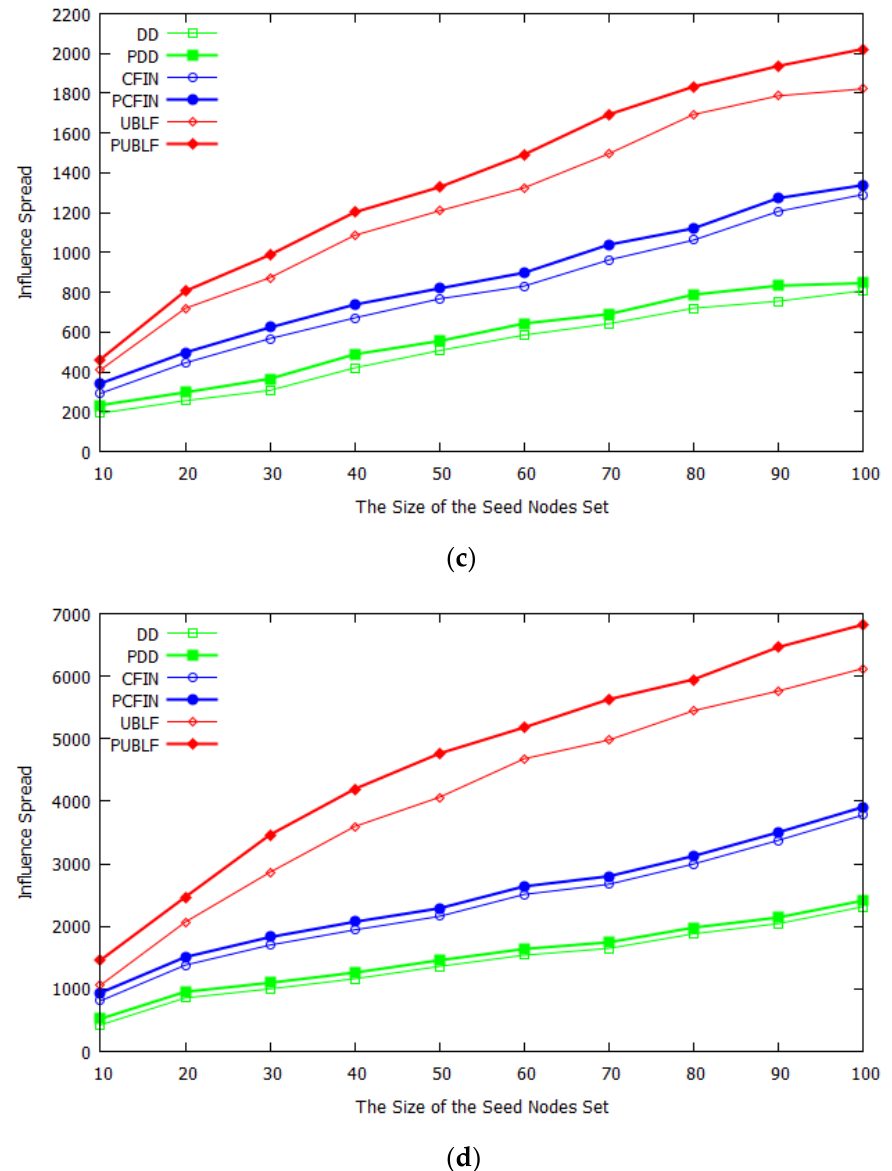
Figure 4. Comparison of the influence spread of classical influence maximization algorithm embedded and not embedded in IMPR framework. ( a ) Comparison of the performance of different algorithms on the CollegeMsg dataset. ( b ) Comparison of the performance of different algorithms on the Mathoverflow dataset. ( c ) Comparison of the performance of different algorithms on the Superuser dataset. ( d ) Comparison of the performance of different algorithms on the Stackoverflow dataset.